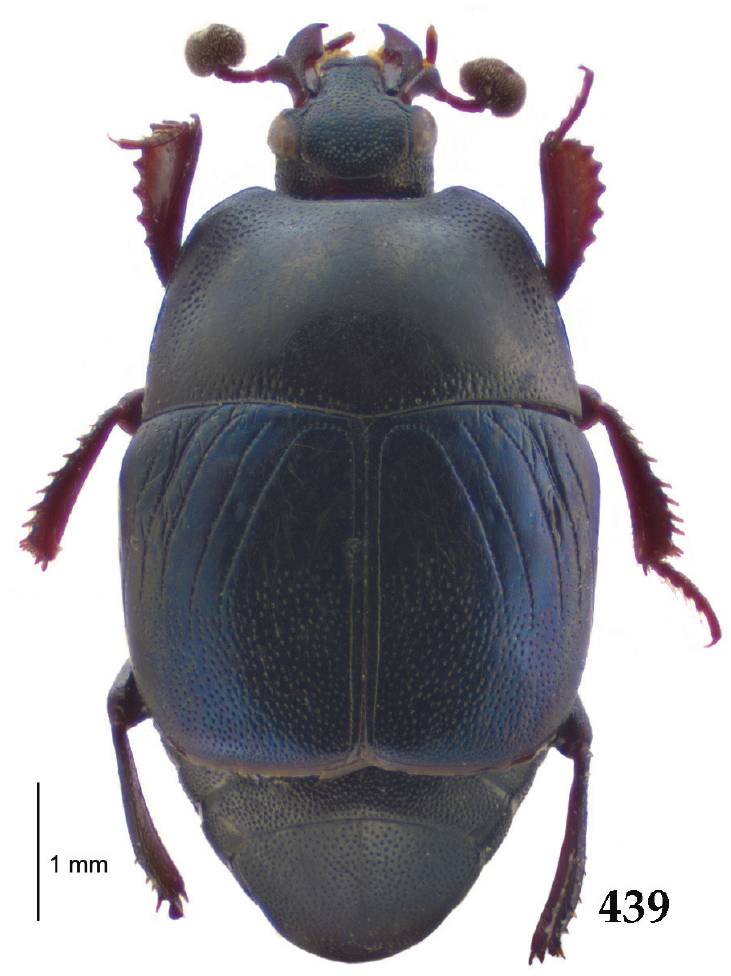
Figure 439. Saprinus ( Saprinus ) grandiclava Kanaar, 1989 habitus, dorsal view.